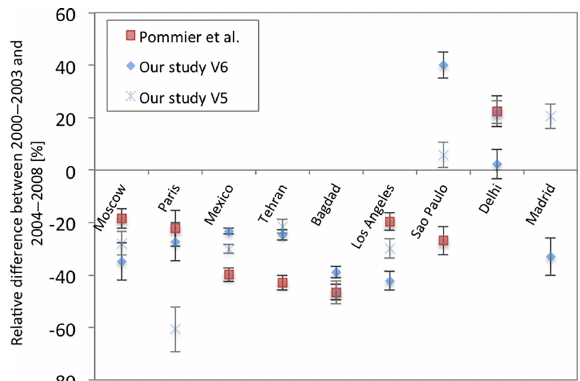
Figure 5. Calculated RDs, comparing results of the satellite-only approach from this study (diamonds for MOPITT version 6, stars for MOPITT version 5) and the study of Pommier et al. (2013; squares). The error bars represent trend uncertainties, following the calculation method that was used in